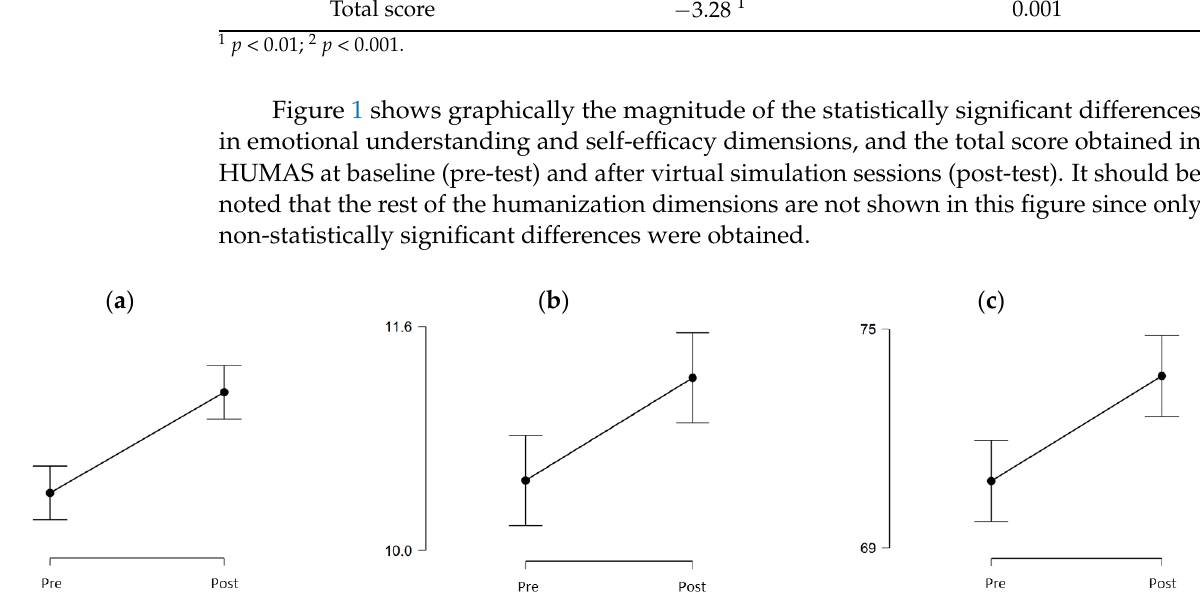
Figure 1. Statistically significant differences in self-efficacy and emotional understanding dimen- sions, and the total score obtained in HUMAS at baseline (pre-test) and after virtual simulation ses- sions (post-test). ( a ) Self-efficaccy, ( b ) Emotional understanding, ( c ) Total score.